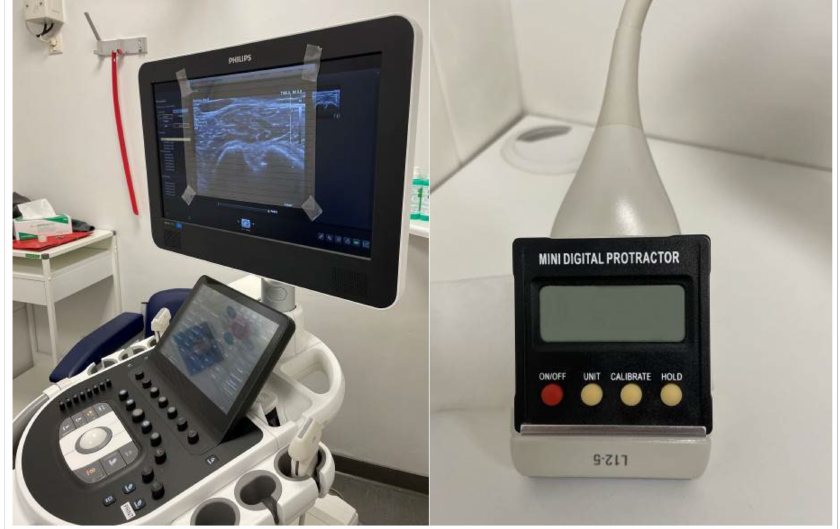
Figure 1. Equipment for sonographically assisted measurement of humeral